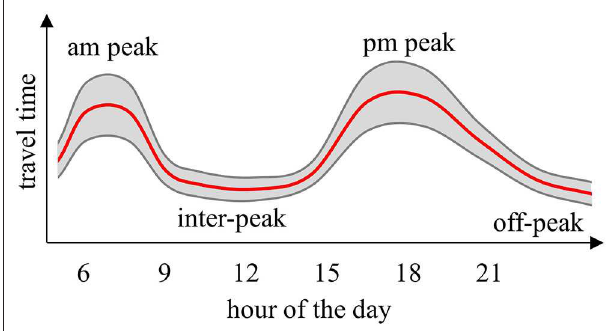
FIGURE 3 | Typical changes of the mean (red) and the variation (gray) of route bus travel times over the course of the day.